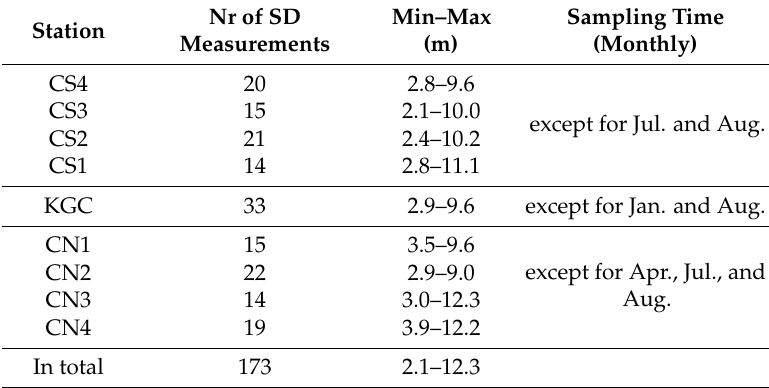
Figure 3. Sampling locations in the southeast arm of Lake Malawi. KGC represents the center of the cage farm, CN1–CN4 represents four sampling stations in the north of KGC, and CS1–CS4 represents four sampling stations in the south of KGC (modified from [29]). Table 2. Stations and number of in situ Secchi disk (SD) measurements used for validation, including minimum and maximum values. KGC represents the center of the cage farm, CN1–CN4 represents four sampling stations in the north of KGC, and CS1–CS4 represents four sampling stations in the south of KGC [29].